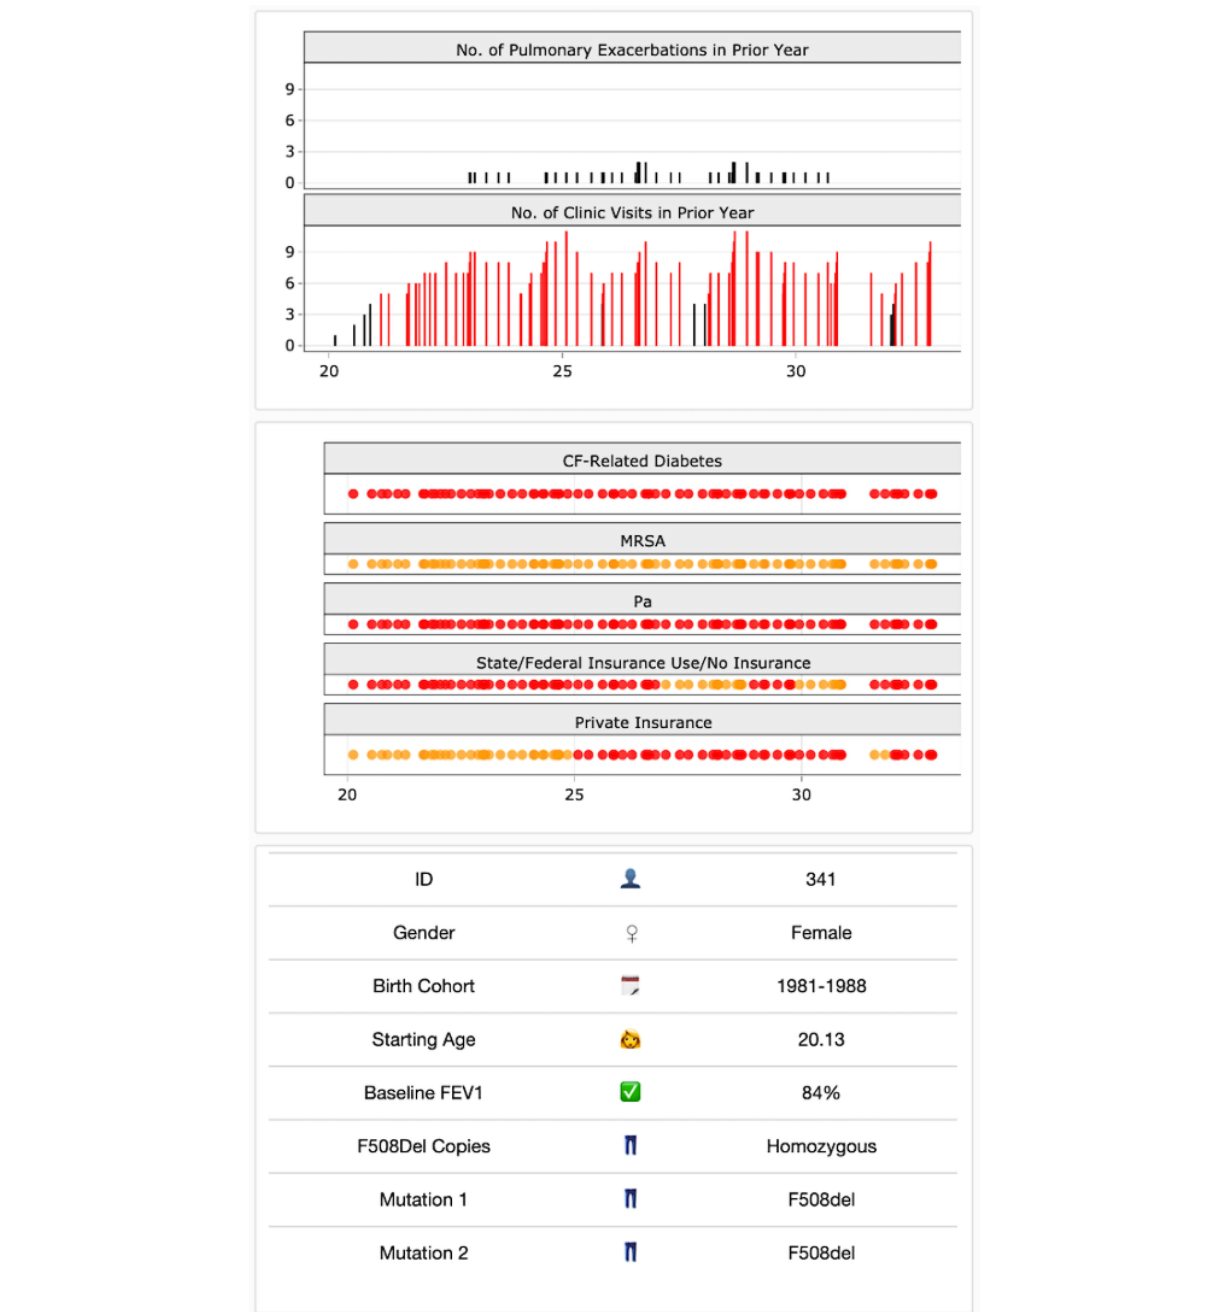
Figure 4. Rightmost panel of Cystic Fibrosis Point of Personalized Detection (CFPOPD). The covariate table (bottom) shows that patient 341 is female, born between 1981 and 1988, enrolled in the Cystic Fibrosis Foundation Patient Registry at age 20, had a baseline of 84% predicted forced expiratory volume in 1 second (FEV1), and is homozygous for F508del copies. The top bar plot shows that she has had few pulmonary exacerbations (PEs) but numerous clinic visits throughout her clinical history. Binary covariate plots (middle) indicate that she has been diagnosed with cystic fibrosis (CF)-related diabetes and had not developed Staphylococcus aureus (MRSA) infection but has experienced chronic Pseudomonas aeruginosa (Pa) infection since age 20. The plots for insurance type indicate that she utilized public insurance at entry and transitioned between public and private insurance, beginning at around 25 years of